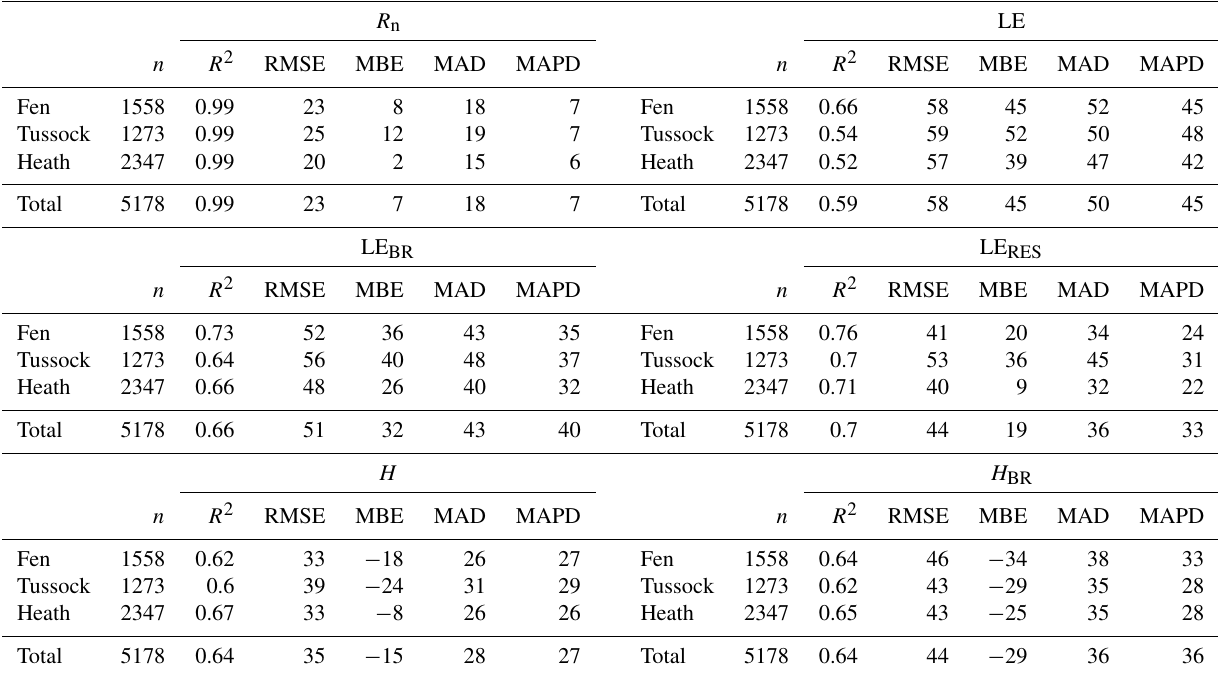
Table 6. Accuracy and error statistics from the comparison of modeled vs. observed unclosed and closed surface fluxes using α PTC of 1.26. n is the number of half-hour periods analyzed. RMSE, MAD and MBE are in Wm − 2 and MAPD is in